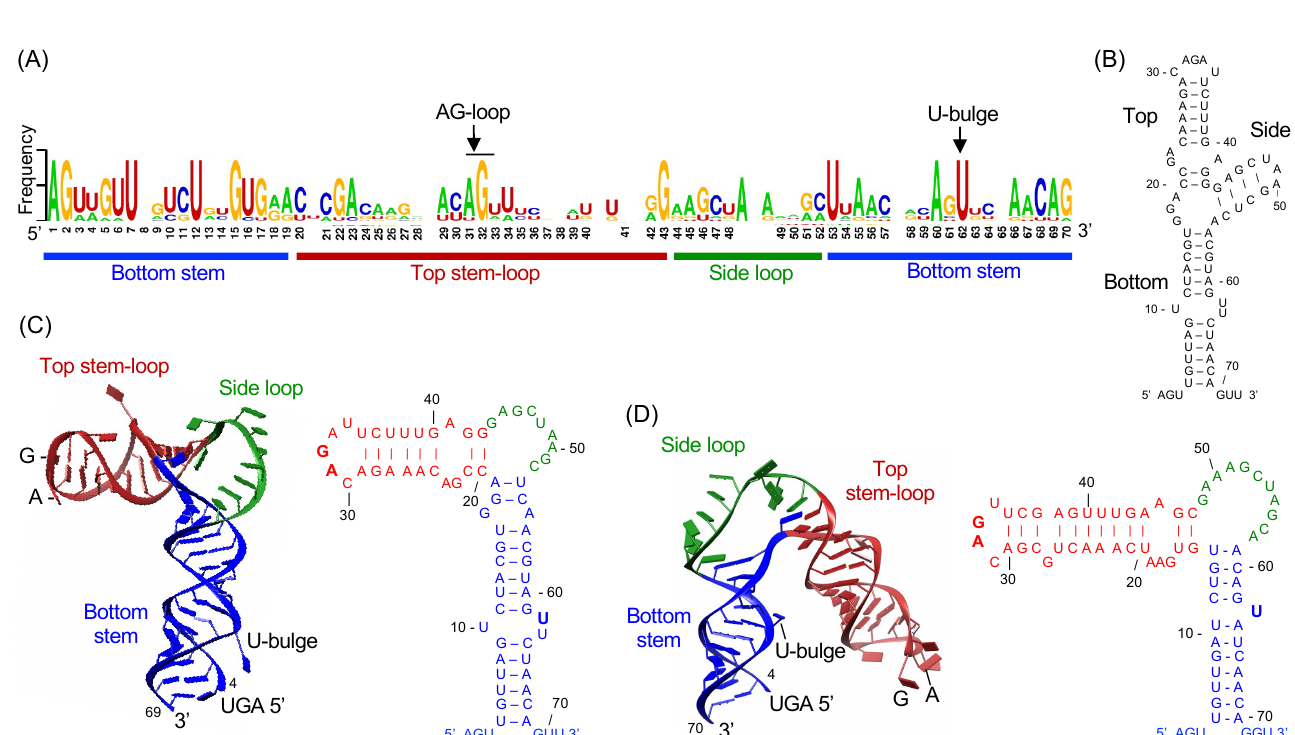
Figure 3. Structure of flavivirus stem-loop A (SLA) promoter. ( A ) Sequence conservation in flavivirus SLAs. A graphical presentation of nucleotide sequences for each position is shown. The overall height of the stack indicates the sequence con- servation at that position, and the height of symbols within the stack indicates the relative frequency of each nucleotide. SLA sequences of DENV1-4 (NCBI accession numbers, NC_001477, NC_001474, NC_001475, NC_002640), WNV (NC_001563), JEV (NC_001437), and ZIKV (KU527068) were used in the alignment. The figure is generated by WebLogo [35]. ( B ) The predicted secondary structure of DENV2 SLA. The secondary structure was predicted by the program RNAfold [36]. ( C ) The crystal structure of DENV2 SLA. Flavivirus SLA consists of a top stem-loop (red), a side loop (green), and a bottom stem (blue). The positions of the U-bulge and AG motif were indicated. The secondary structure based on the tertiary structure is shown on the right. ( D ) The crystal structure of ZIKV SLA. The crystal structure of ZIKV SLA and its secondary structure are shown. ZIKV SLA is colored as in ( C